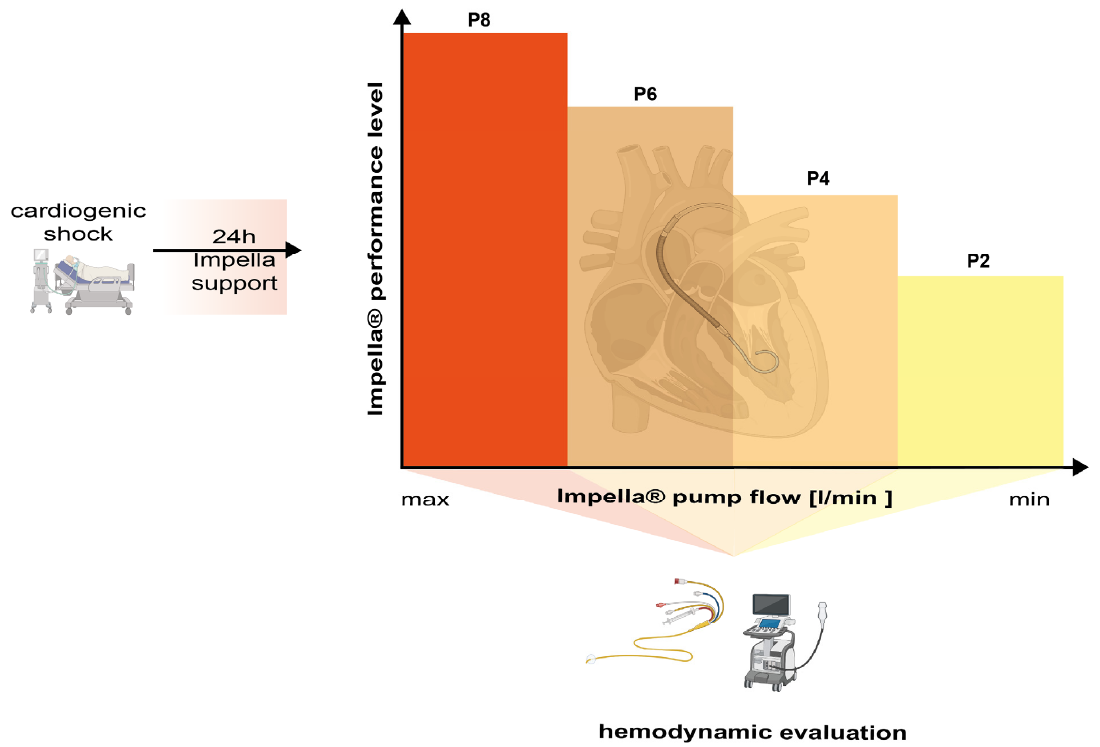
Figure 2. Study set up for measuring the primary outcome after 24 h of Impella ® support post- implantation via PAC and TTE(Graphic generated using BioRender©). Table 4. Secondary endpoints of the JenaMACS study.